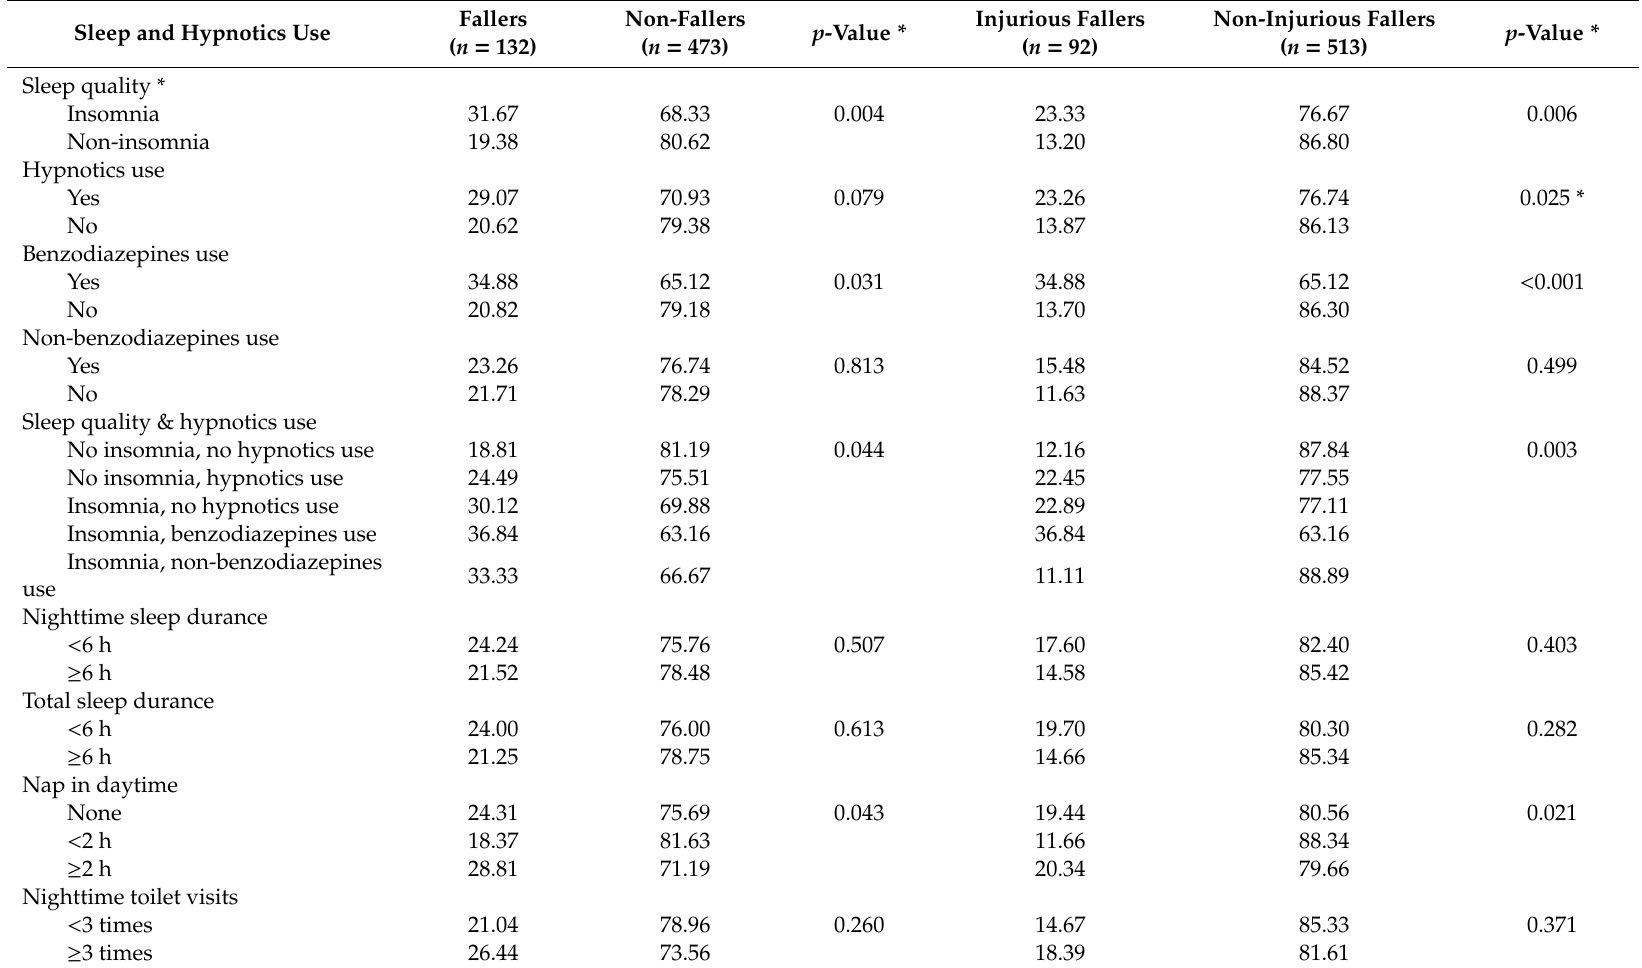
Table 2. Unadjusted relationship of sleep quality and hypnotics use with falls or injurious falls in the study participants ( n = 605). Sleep and Hypnotics